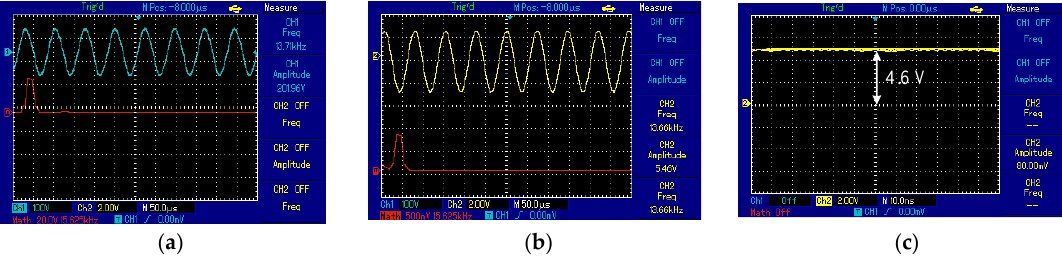
Figure 13. The voltage waveforms using second topology at 20 cm for measurement unit: ( a ) transmitter coil, ( b ) receiver coil, and ( c ) voltage load.